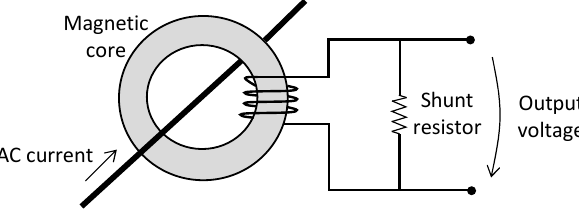
Figure 2. Current sensor.